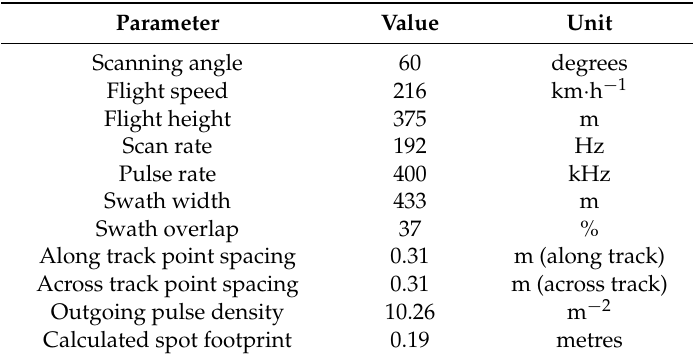
Table 1. LiDAR data acquisition